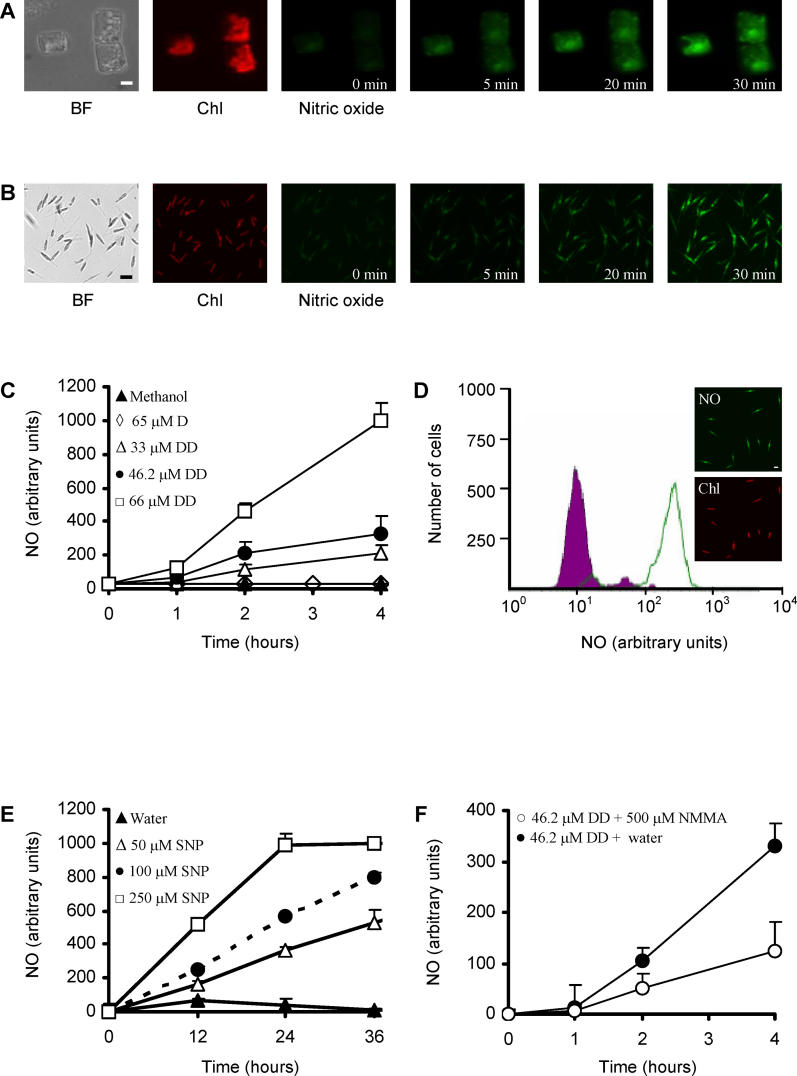
DD Induces NO Generation in DiatomsMicrographs depicting NO generation over time in response to DD (66 μM [10 μg/ml]) in T. weissflogii (A) and P. tricornutum (B). (C) Monitoring of NO production in P. tricornutum in response to a range of DD concentrations; (D) Cytogram showing NO generation 15 min after addition of DEANO (2 mM) to P. tricornutum cells (filled violet indicates the KOH control; open green indicates DEANO). Insets show epifluorescence micrographs of the DEANO-treated cells. (E and F) Relative accumulation of NO in P. tricornutum cells following treatment with SNP (E) or NMMA prior to exposure to DD (F).In all experiments, NO generation was assayed using the fluorescent probe DAF-FM. Data in (C), (E) and (F) are means plus standard deviation from four experiments. Representative data from at least four experiments are shown in (A), (B), and (D). Experiments shown in (C), (D), and (F) were performed by flow cytometry, and in (E) using a fluorescence microplate reader.BF, bright field; Chl, chlorophyll-derived red autofluorescence; D, (2E)-decenal. Scale bars represent 5 μm.